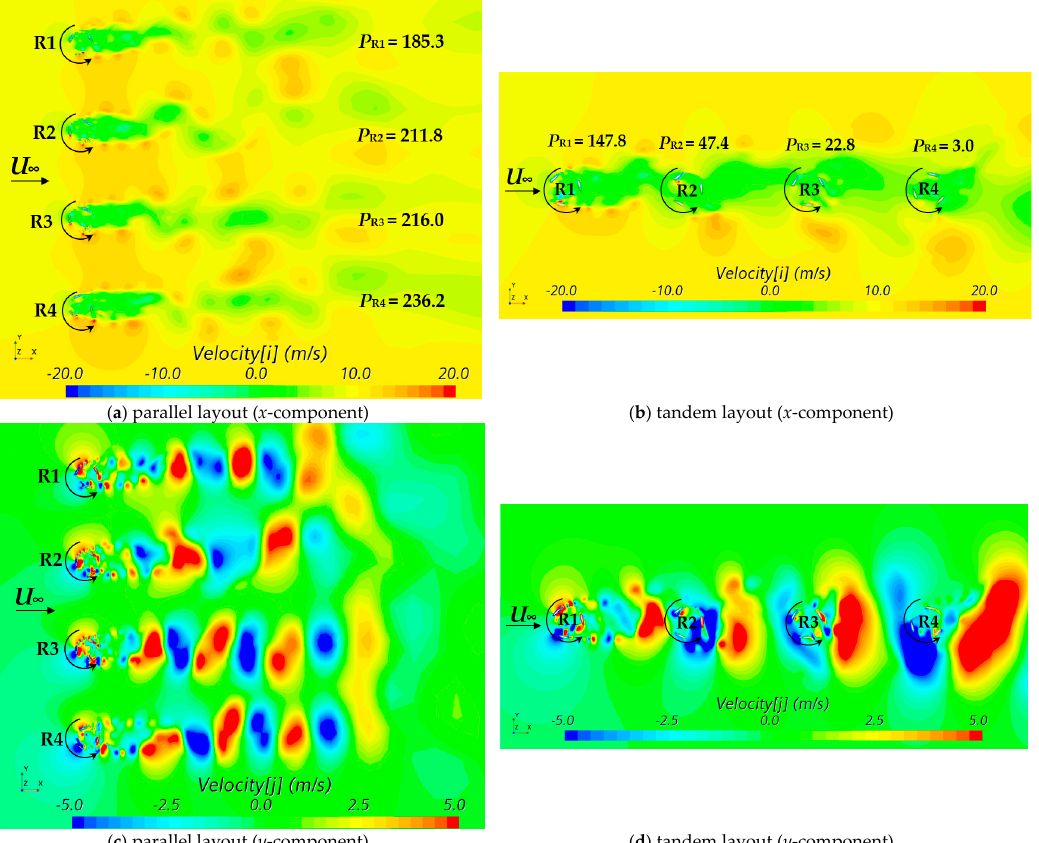
Figure 20. CFD results using the DFBI model of the two kinds of four-rotor layouts; ( a ) x -component distribution in the parallel array; ( b ) x -component distribution in the tandem array; ( c ) y -component distribution in the parallel array; ( d ) y -component distribution in the tandem array. The distributions show the unsteady velocity field at the time of 4 s (see Appendix C).